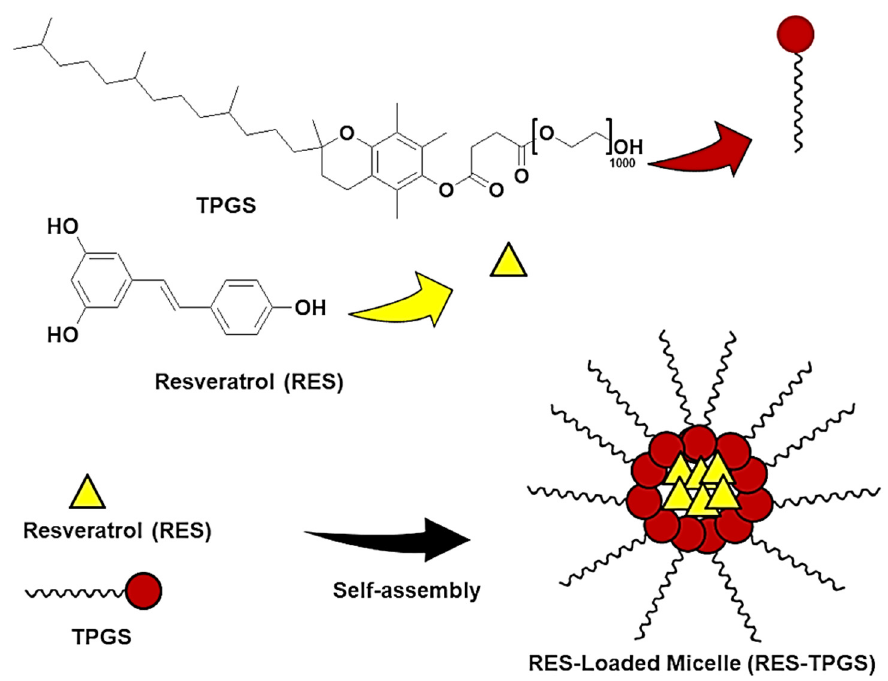
Figure 1. Chemical structures of TPGS and RES and a schematic representation of the micelles.